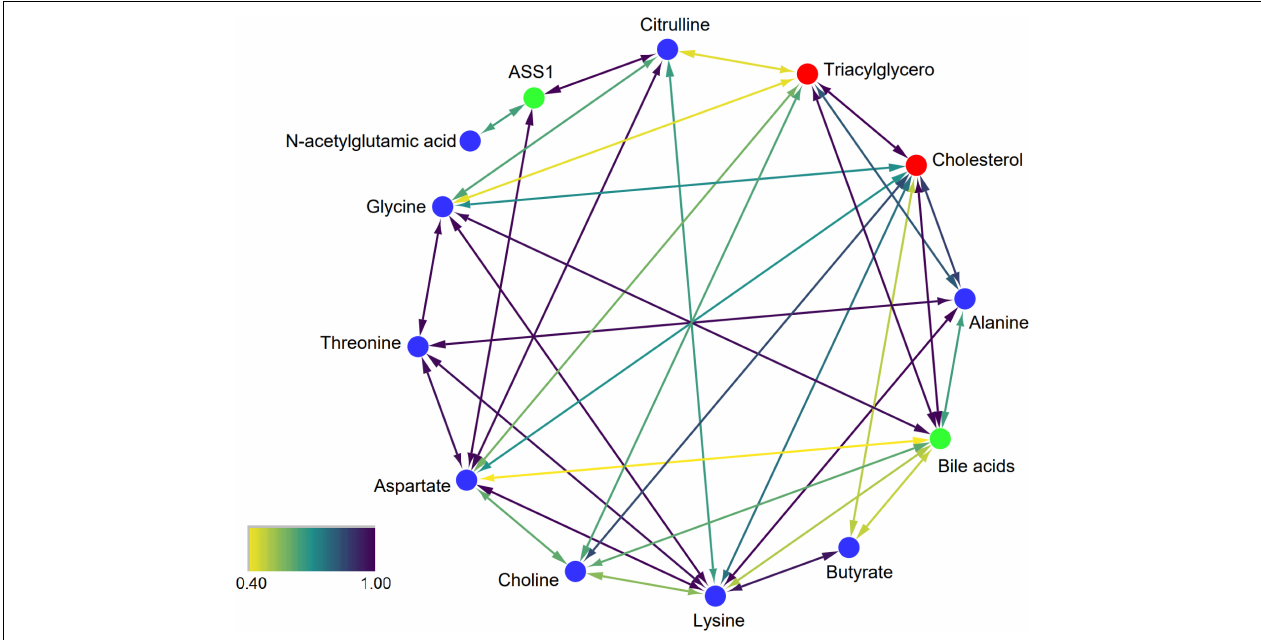
FIGURE 6 | Interaction network of biomarkers. Blue, red, and green nodes represent biomarkers, CVD-related targets, and intermediate chemicals, respectively. The color scale represents the strength of confidence. A higher value represents a stronger data-support